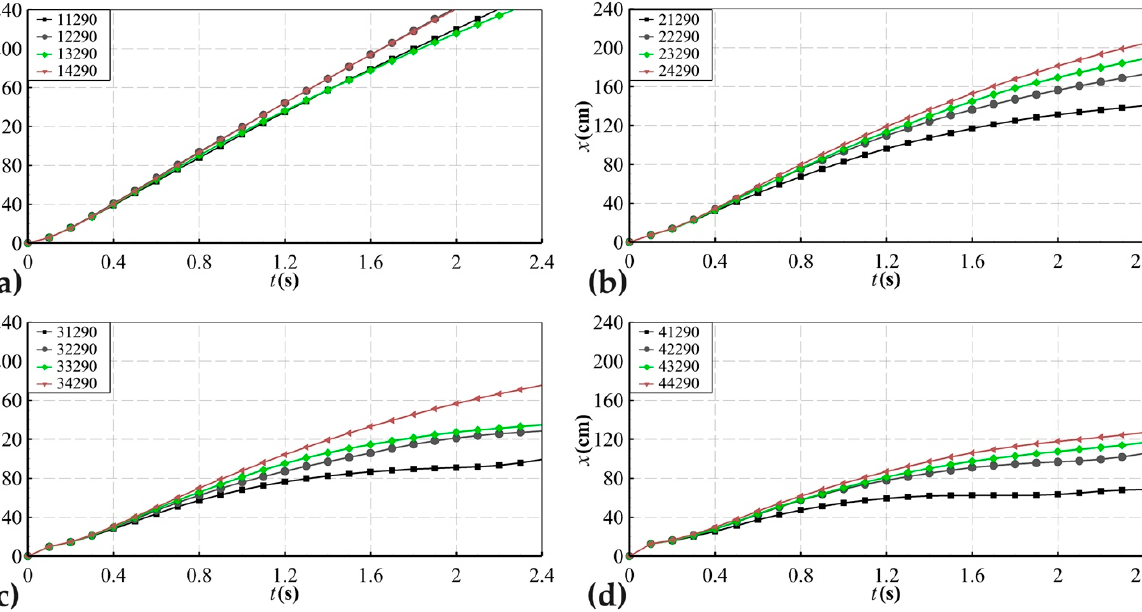
Figure 14. Comparison of the location of the center of gravity of the entire container group in the x direction after starting the drift at a 0.1 s interval. ( a ) N x = 1, N z = 2, and N y = 1, 2, 3, 4; ( b ) N x = 2, N z = 2, and N y = 1, 2, 3, 4; ( c ) N x = 3, N z = 2, and N y = 1, 2, 3, 4; and ( d ) N x = 4, N z = 2, and N y = 1, 2, 3, 4.